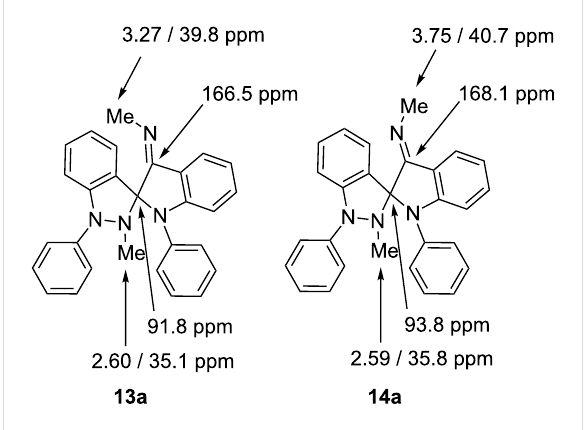
Figure 1: Diagnostic 1 H and 13 C NMR chemical shifts of the Z and E configuration isomer in CDCl 3 .